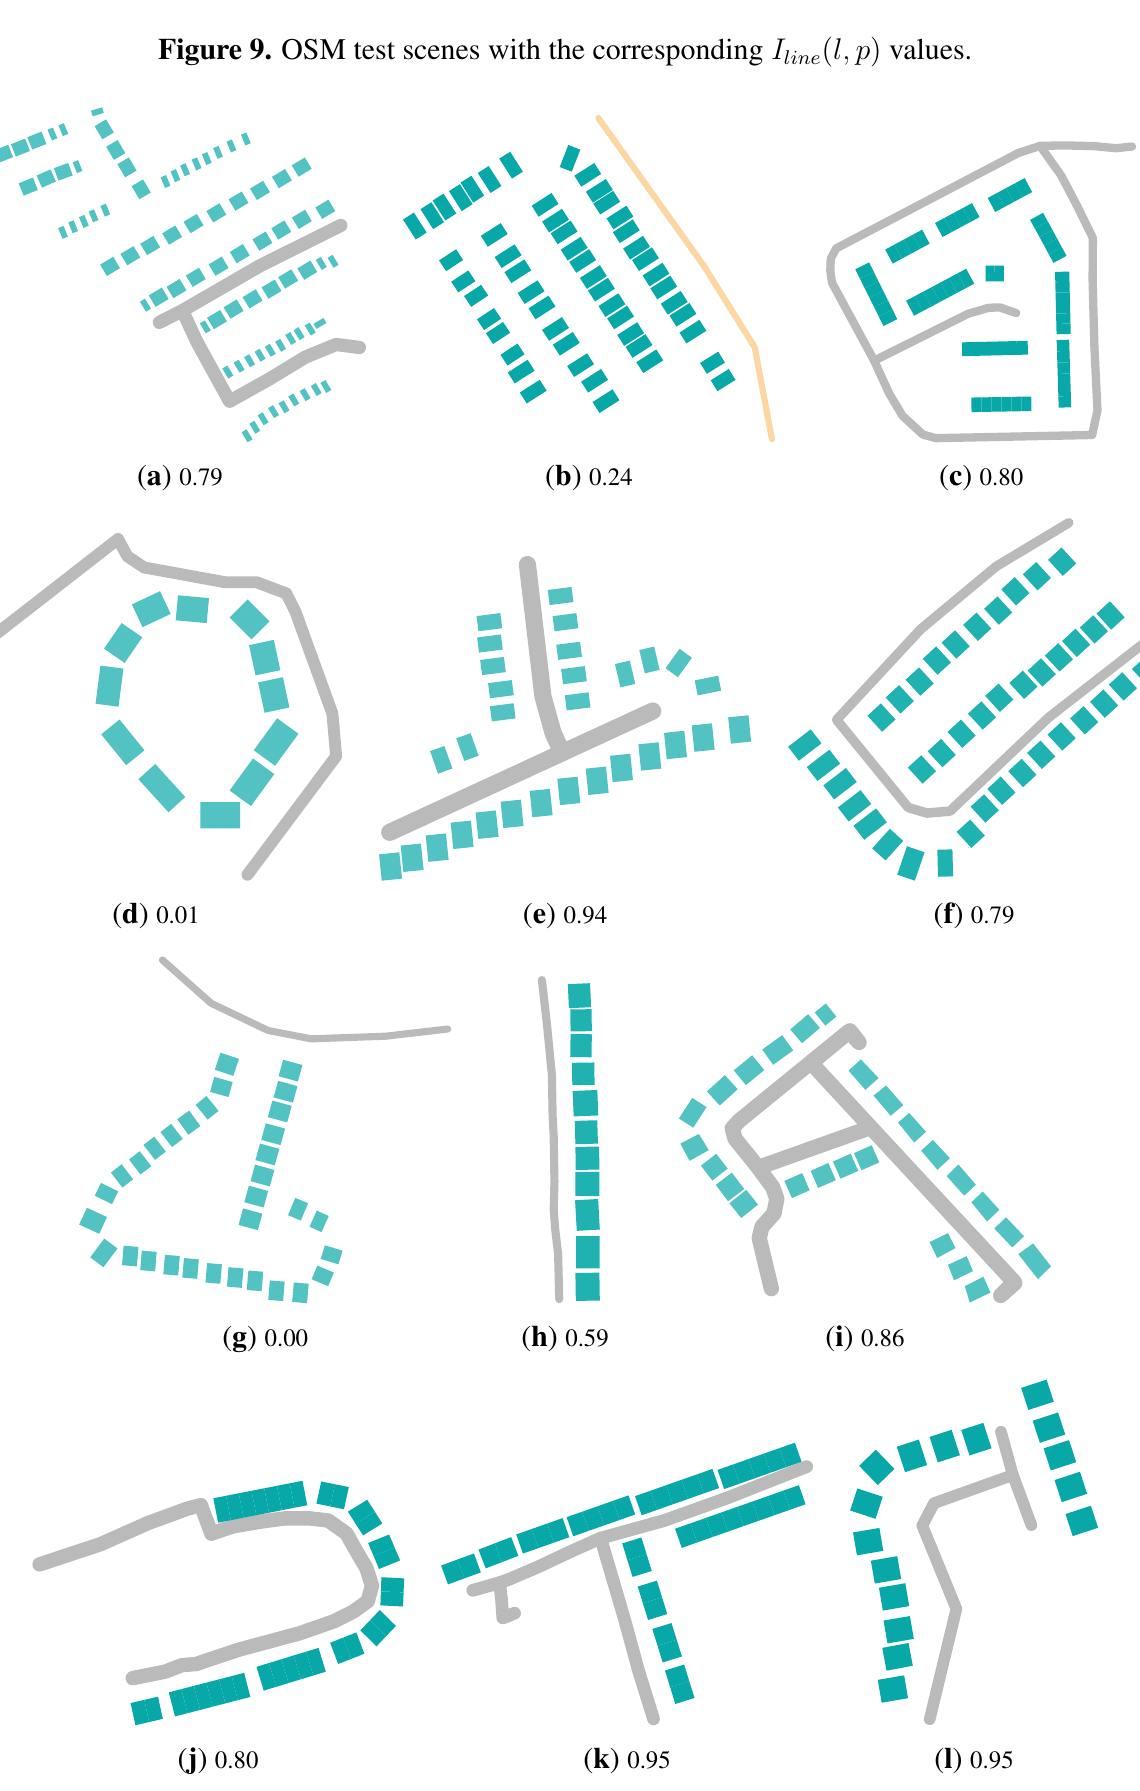
Figure 9. OSM test scenes with the corresponding I